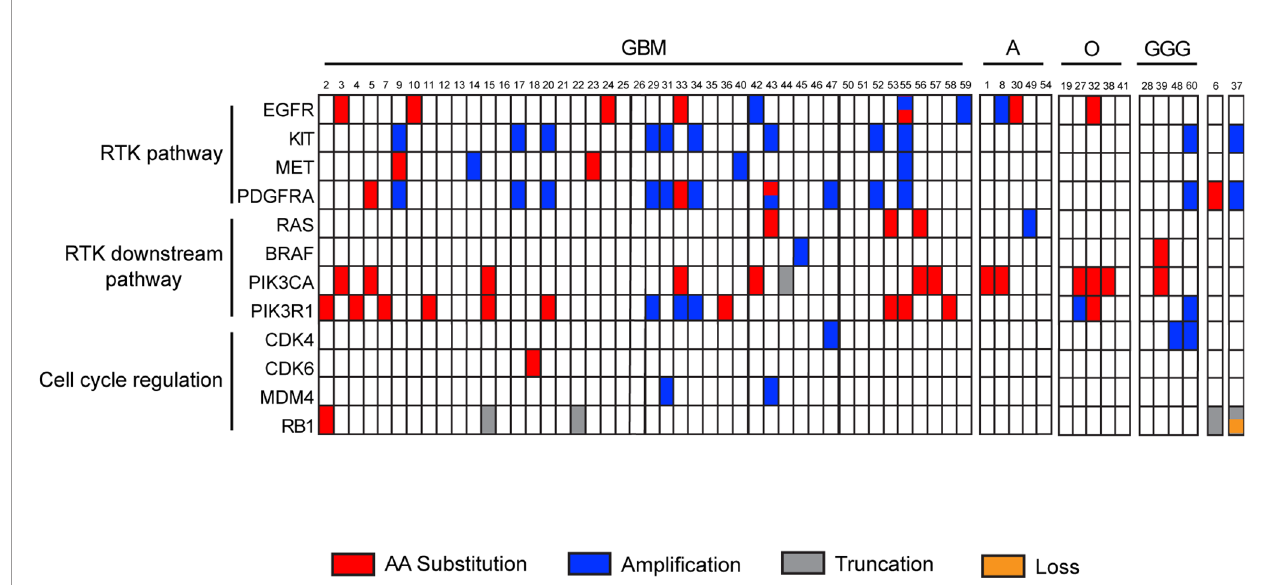
FIGURE 6 | Landscape of recurrent actionable alterations in malignant gliomas. Summary of investigated actionable mutated genes detected by the Glio-DNA panel. Samples are subdivided into groups dependent on diagnostic pro fi le. Single amino acid substitutions are shown in red, truncations in grey, copy number ampli fi cations or deletions in blue and orange, respectively. Sample 6 is a case of gliosarcoma while sample 37 is a case of diffuse midline glioma. GBM, glioblastoma; A, astrocytoma; O, oligodendroglioma; GGG, ganglioglioma; RTK, receptor tyrosine